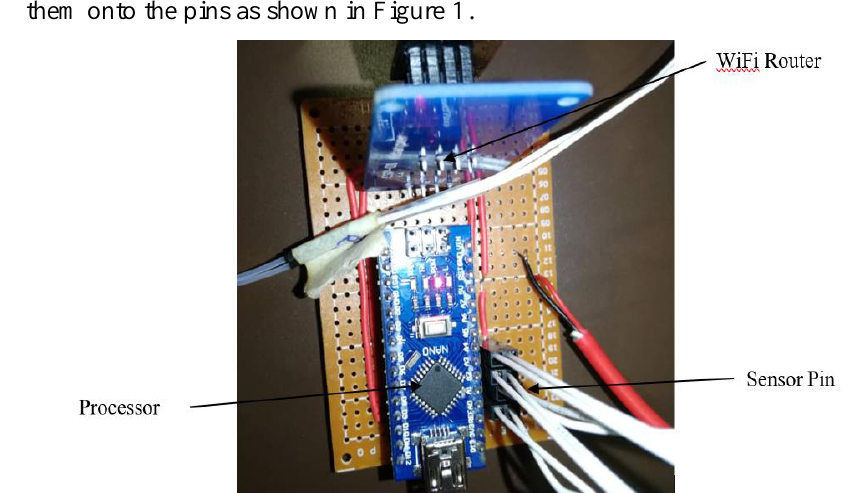
Figure 1. Installation of processor, Wi-Fi router, and sensors on circuit board c.